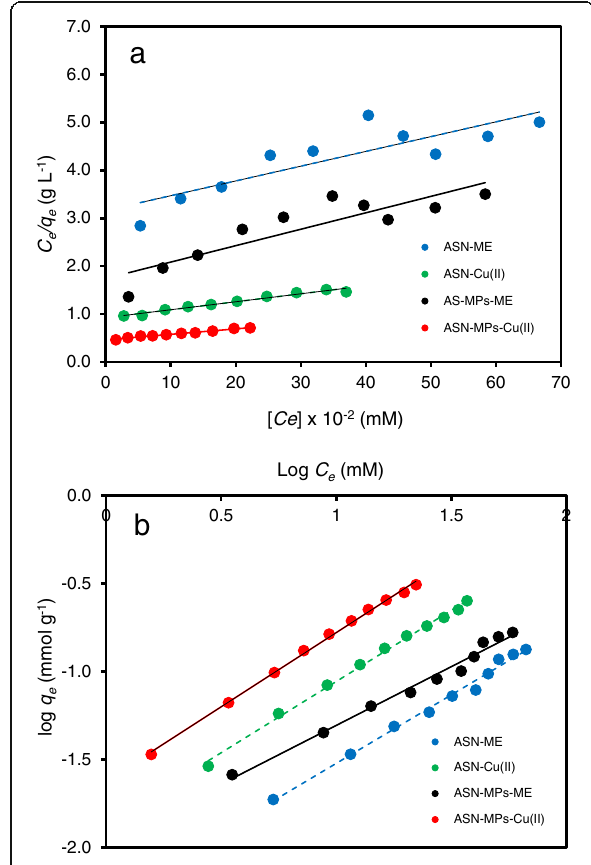
Fig. 10 The liniear regression of ME and Cu(II) cations on ASN and ASN-MPs by comparing the equilibrium adsorption data with the ( a ) Langmuir and ( b ) Freundlich adsorption models